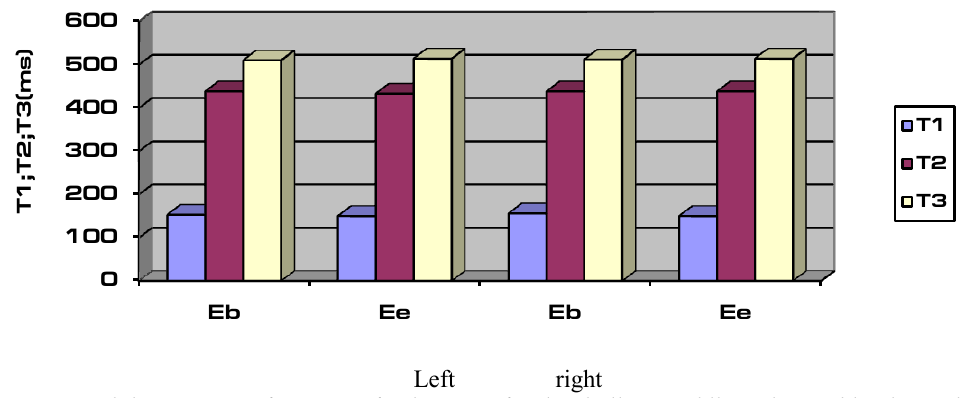
Left right Figure 1. Temporal descriptions of passing of pulse wave for the shallow, middle and main blood vessels of cerebrum (left and right